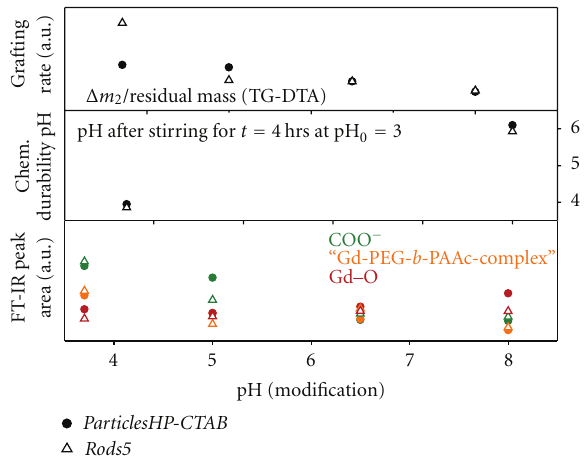
Figure 8: Trends in physico-chemical properties of PEG- b -PAAc modified ParticlesHP-CTAB and Rods5 as a function of modification